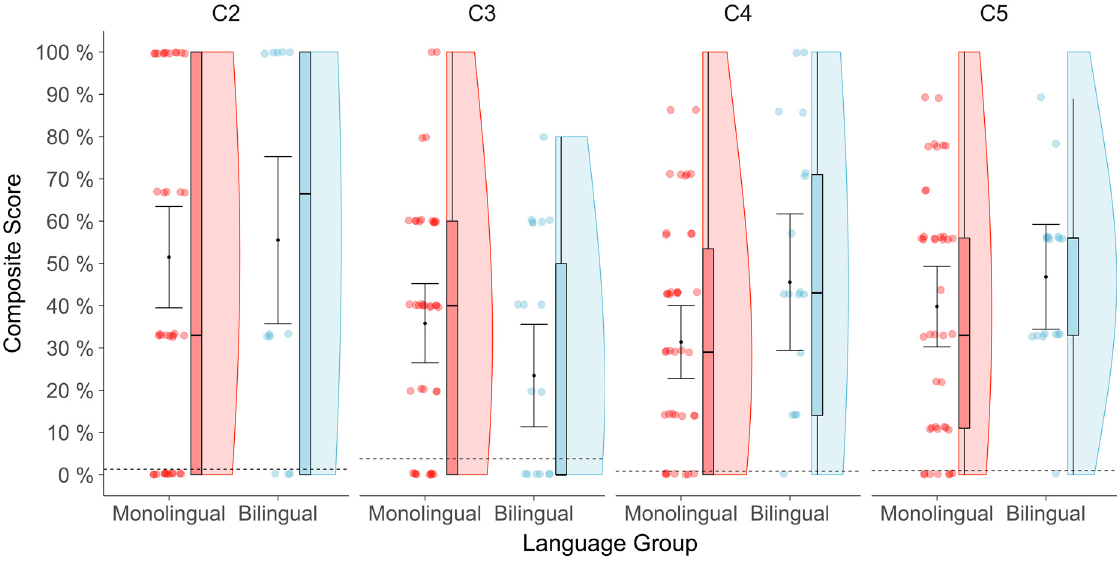
Figure 4. Distribution of Composite Scores by Condition and Pose. The average mean composite score in the Test condition per sequence was: M 2 -step = 57.26%; M 3 -step = 33.75%; M 4 -step = 38.45%; M 5 -step = 44.38%) The horizontal dashed lines represent the average mean composite score in the Baseline condition ( M 2 -step = 1.32%; M 3 -step = 3.80%; M 4 -step = 0.86%; M 5 -step = 0.99%).